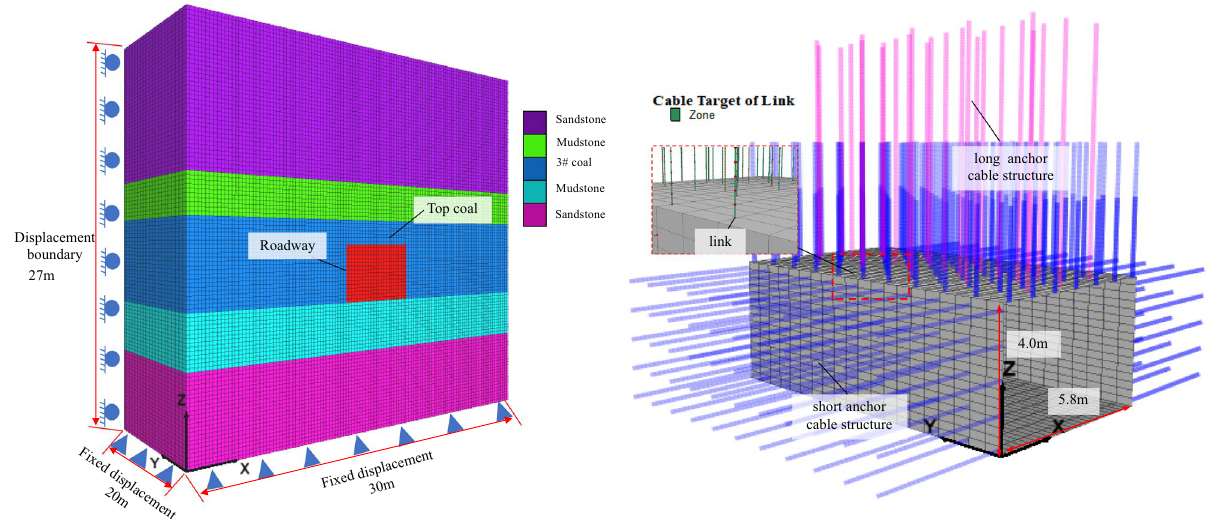
Figure 5. 3D model and supporting structure of the top coal roadway in thick